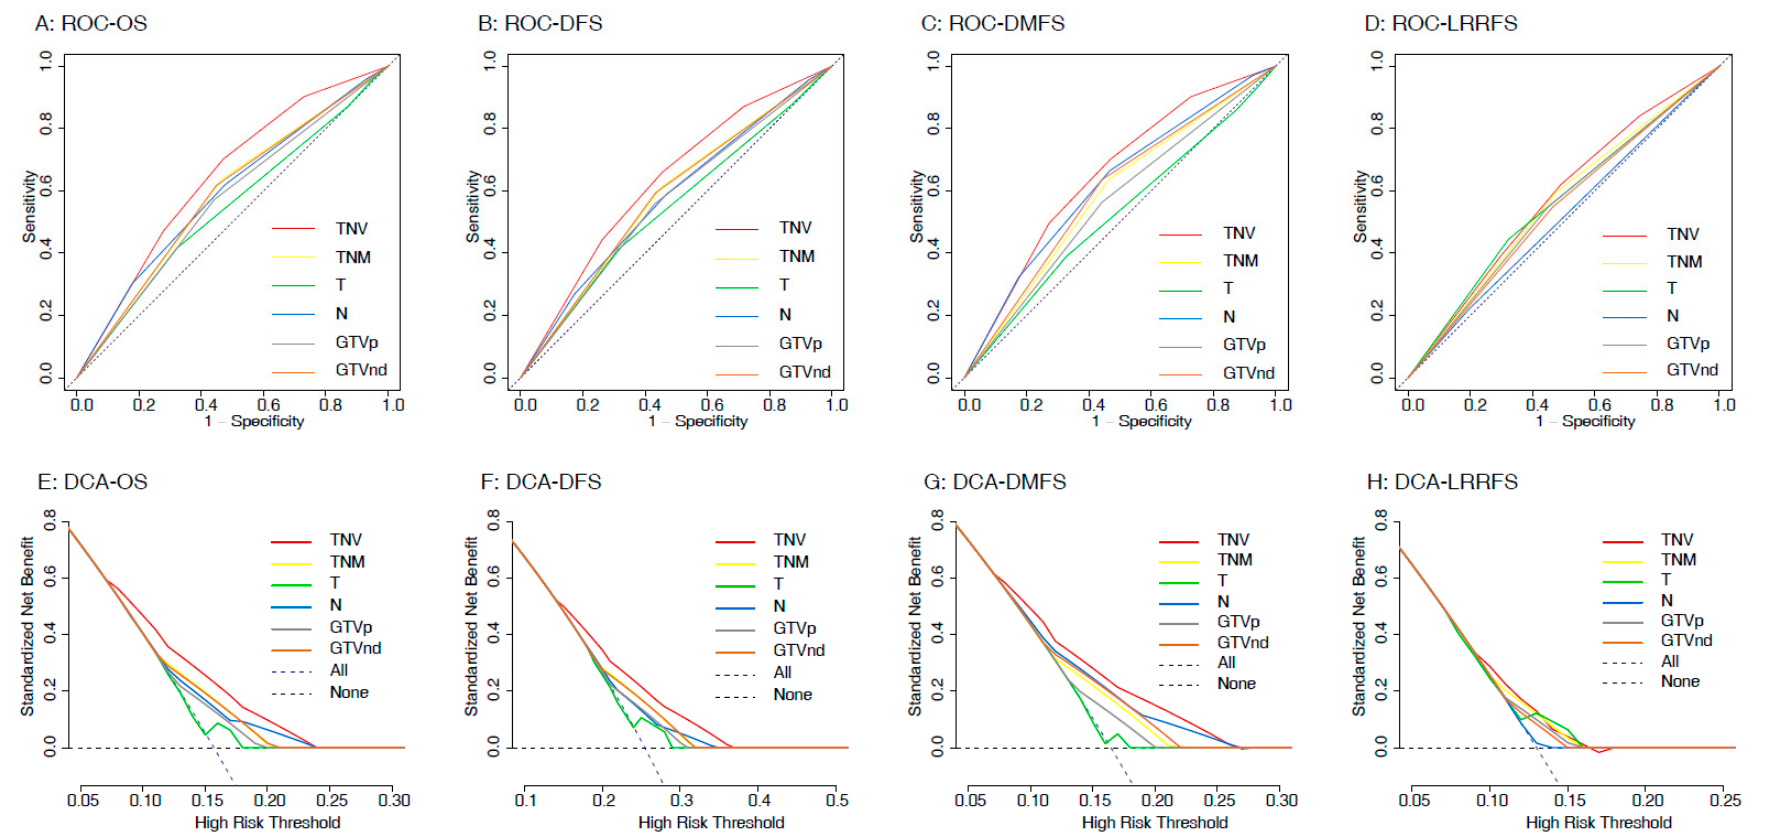
Figure 4. Receiver operating characteristic (ROC) curve and decision curve analyses (DCA) comparing the accuracy of TNV risk stratification system with GTVp/GTVnd and eighth edition TNM stage for predicting overall survival (OS), disease-free survival (DFS), distant metastasis-free survival (DMFS), and local relapse-free survival (LRFS).